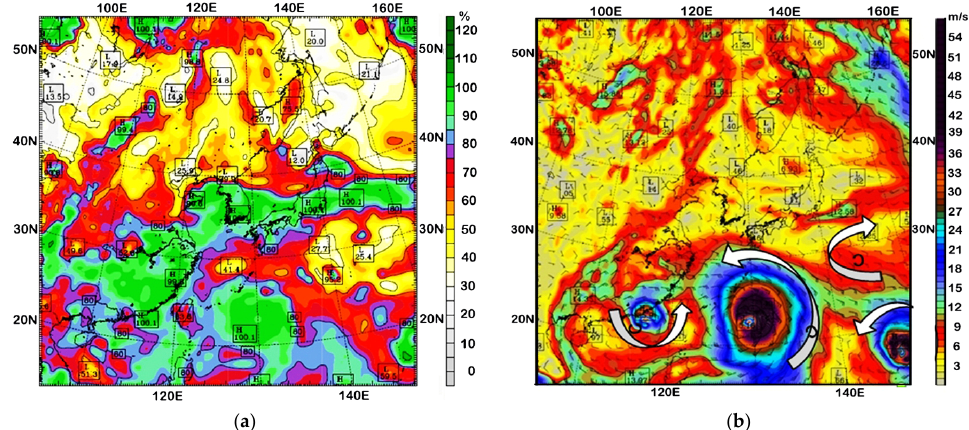
Figure 20. ( a ) Relative humidity (%) and ( b ) wind (m/s) at 1.5 km height (850 hPa) by WRF-3.6 model at 09:00 LST, 9 July 2015. The three typhoons’ steering as a result of multiple interactions among them (STS Linfa (bottom-left), TY Chan-Home (bottom-center), and TY Nangka (bottom-right)) cause their intensification and decay.